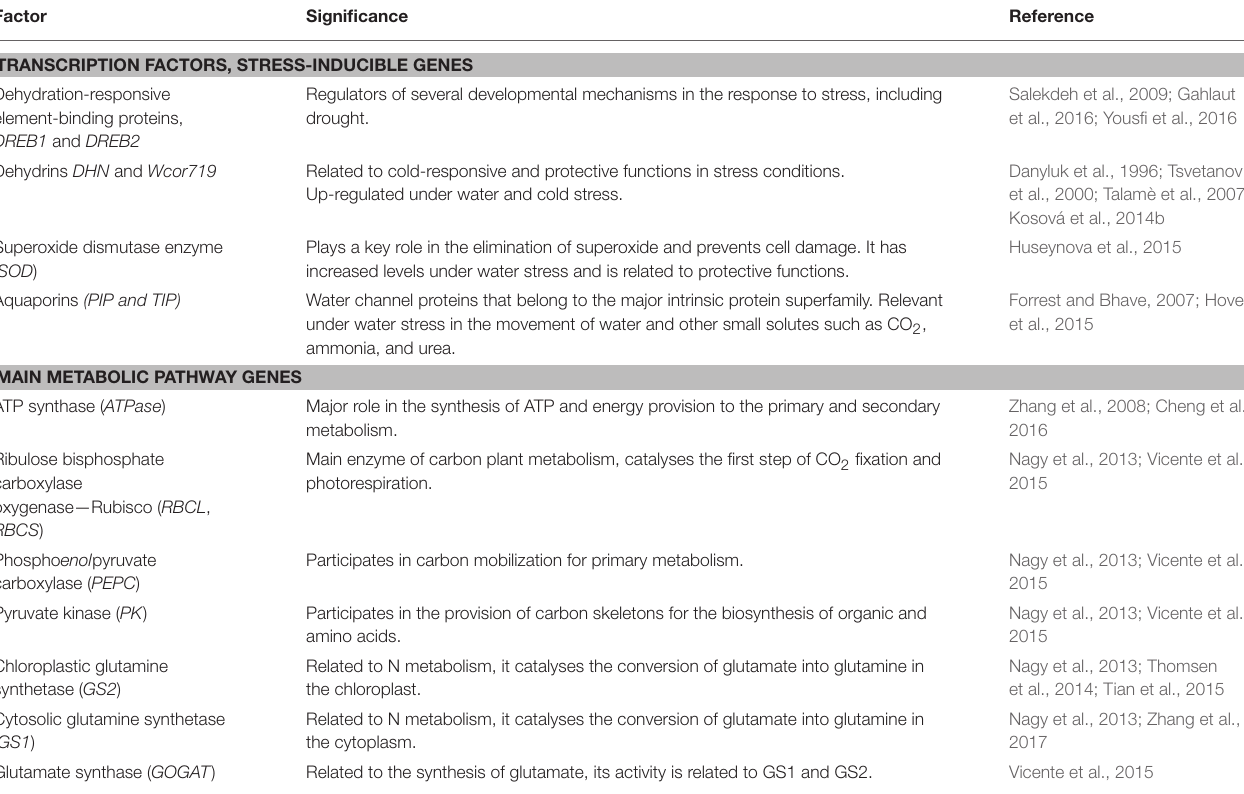
TABLE 1 | Transcription factors, stress-inducible genes, and main metabolic pathway genes in wheat.